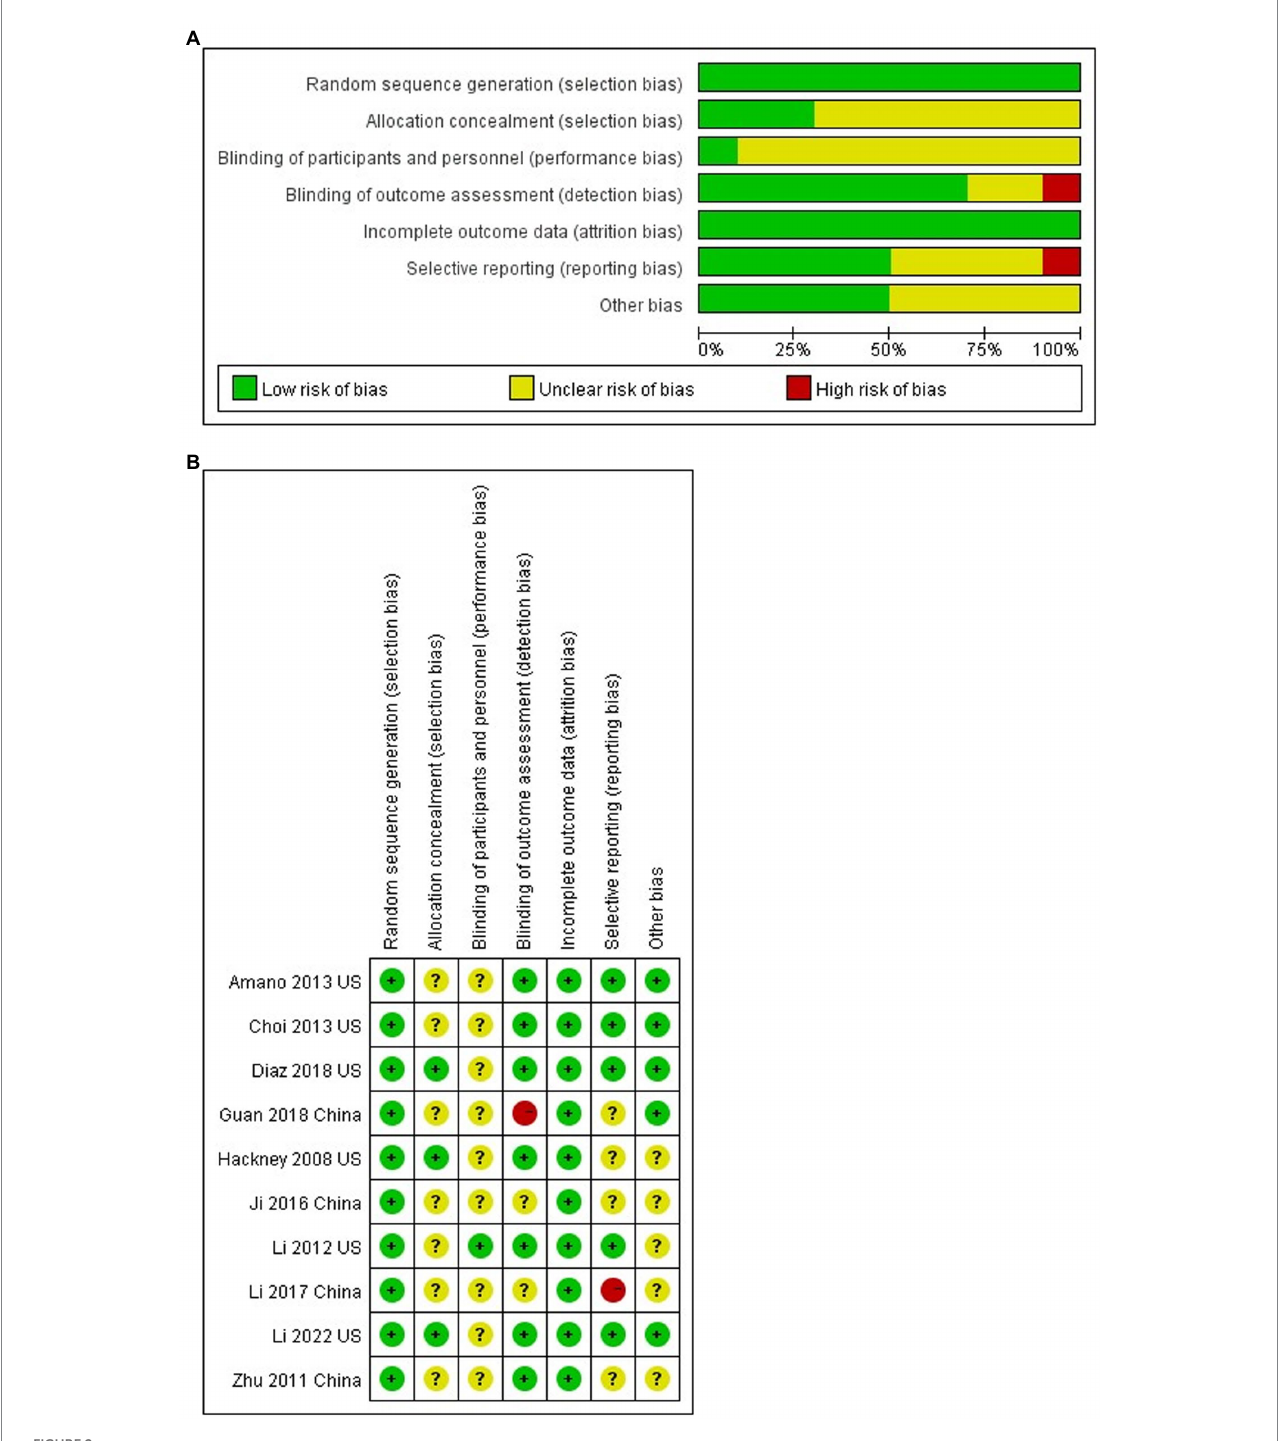
FIGURE 2 (A) Risk of bias graph. (B) Risk of bias